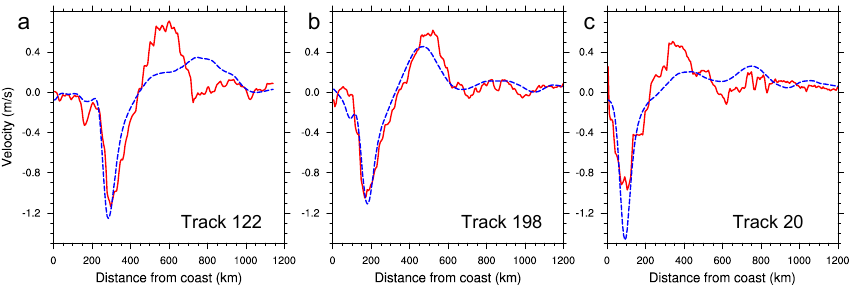
Figure 3. Along-track geostrophic velocities averaged over the period of time common to the model and satellite data (from October 1992 to December 2007) for model data (blue) and satellite data